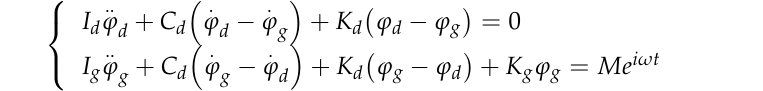
Figure A1. Dual degrees of freedom torsional system. According to D’Alembert’s principle combined with the equivalent model, the re-